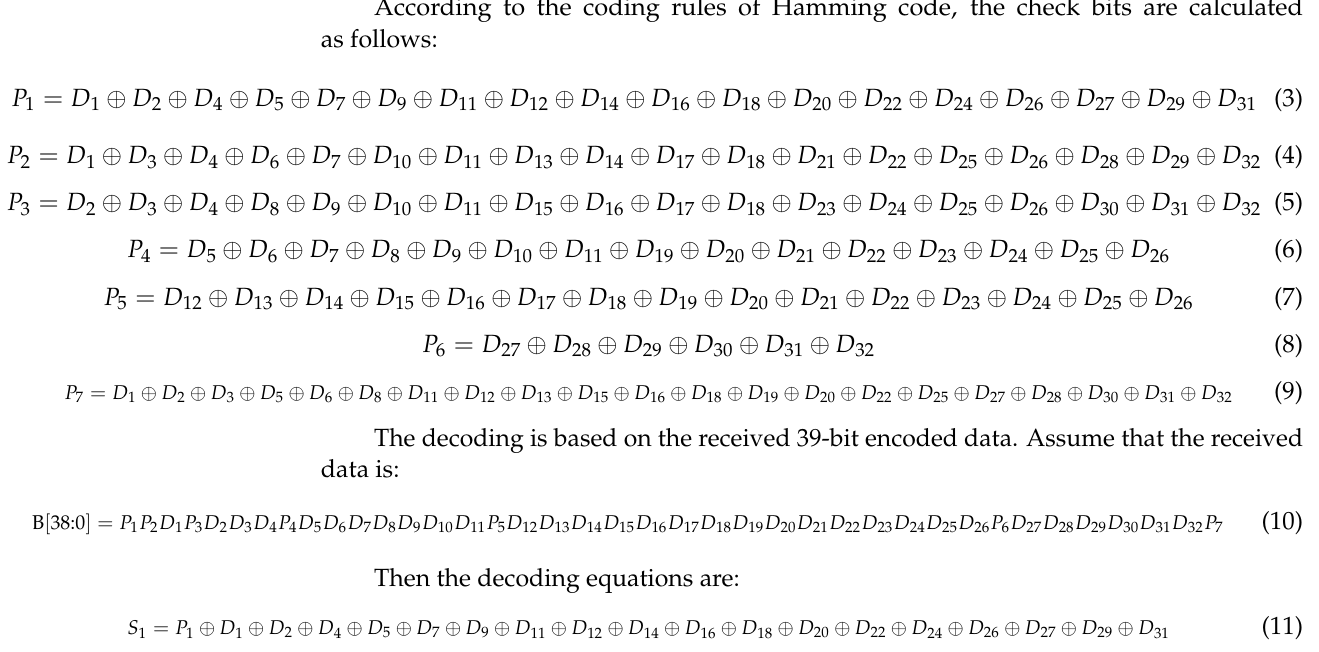
Figure 3. Simple model of the processor core (3-stage).